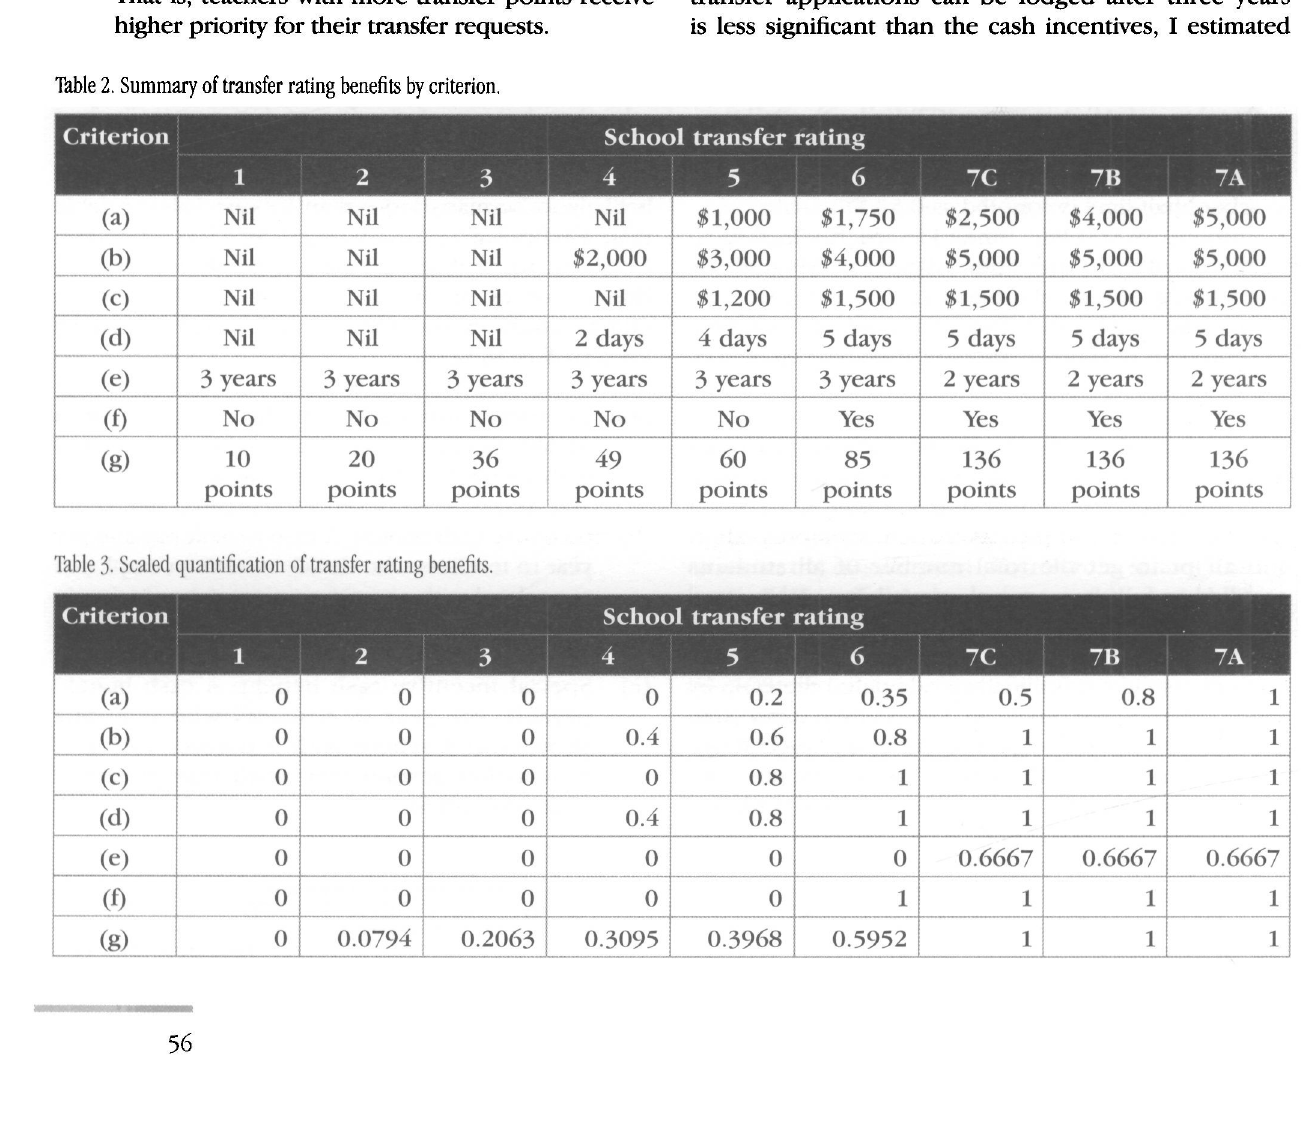
Table 2. Summary of transfer rating benefits by criterion.